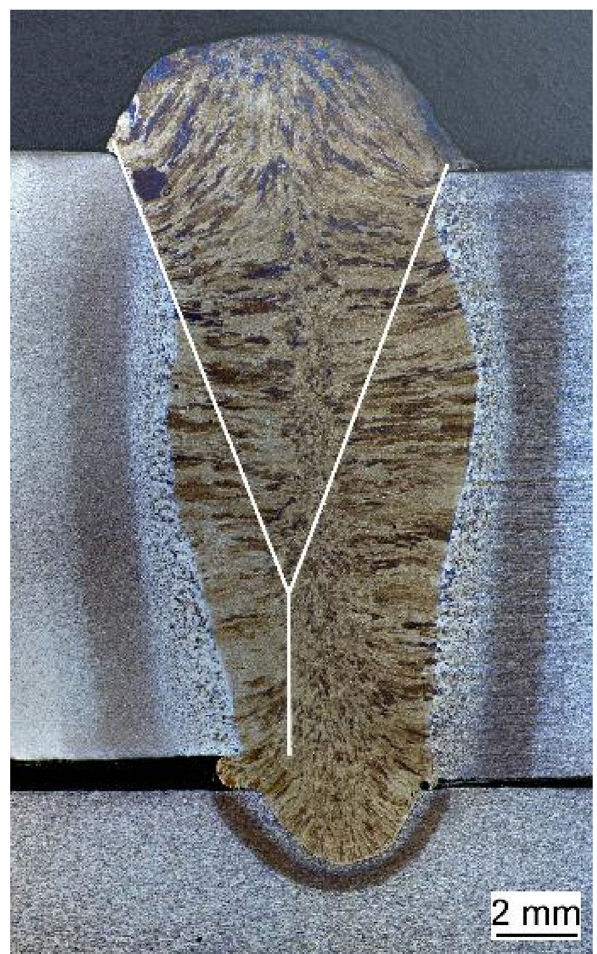
Figure 13. Butt joint 15 mm thickness of base-plate Y-grove weld seam preparation (2 bar).